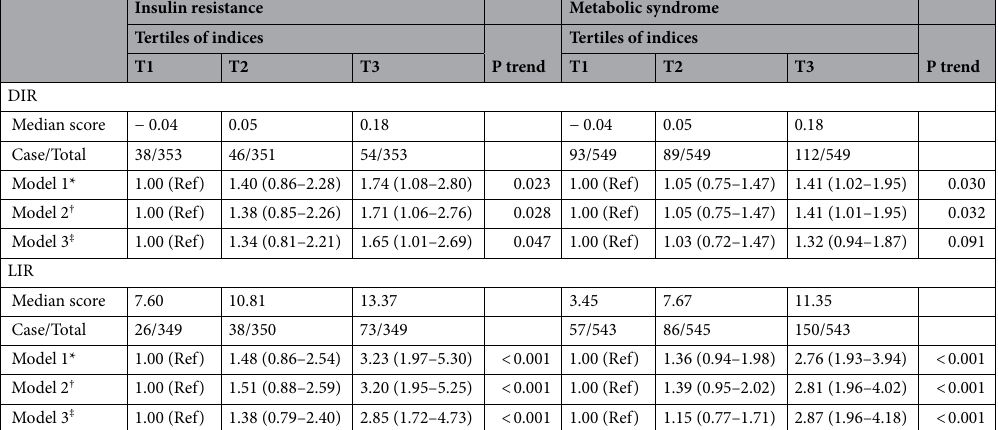
Table 3. The association between the insulinemic dietary and lifestyle indices with the incidence of insulin resistance and metabolic syndrome: the Tehran Lipid and Glucose Study. *Model 1: adjusted for age and sex. † Model 2: adjusted for model 1 and energy intake, smoking, education level, occupation status, and physical activity (only for DIR). ‡ Model 3: adjusted for model 2 and baseline VAI (for DIR) and TG to HDL-c ratio and waist residual BMI (for LIR).